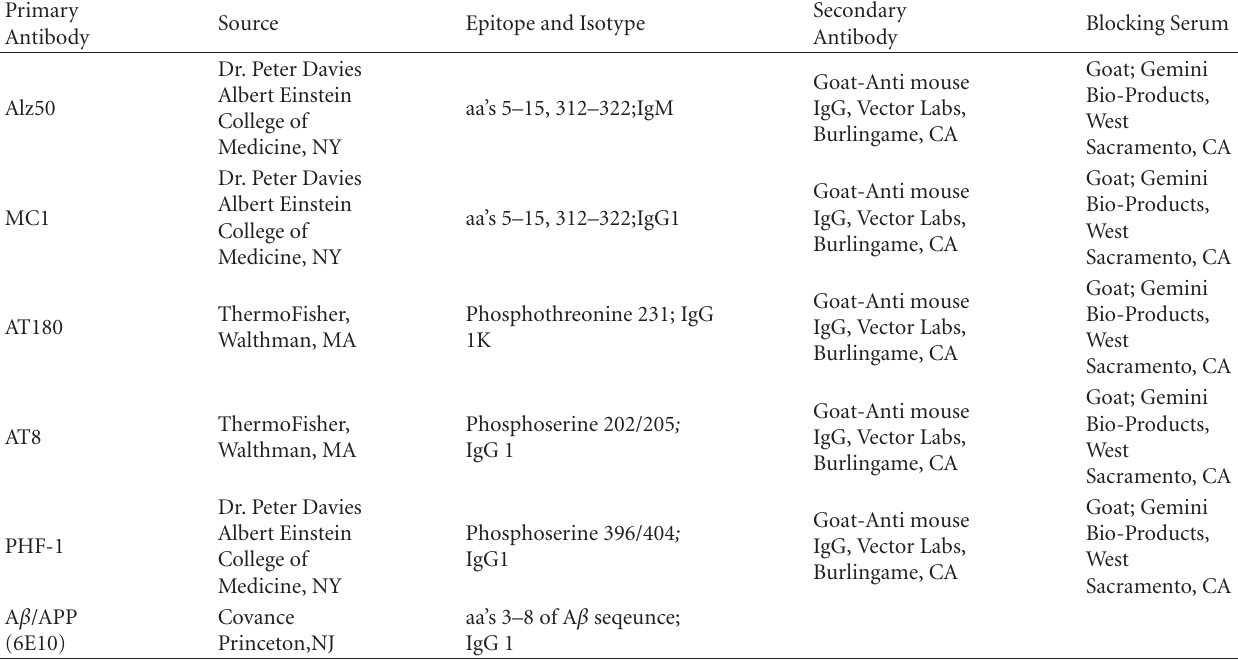
Table 1: Summary of Antibodies and